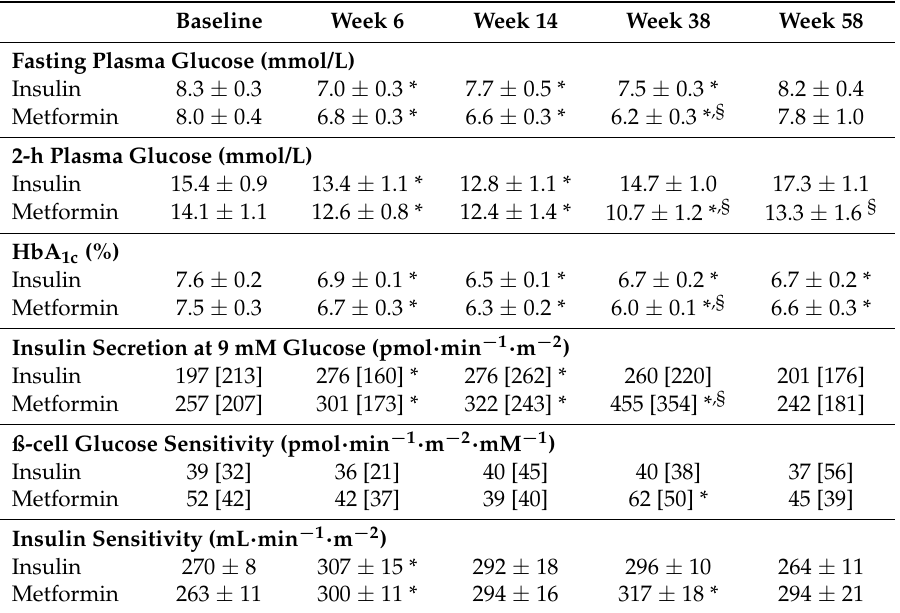
Table 2. Time-course of glycaemic outcomes and their physiological